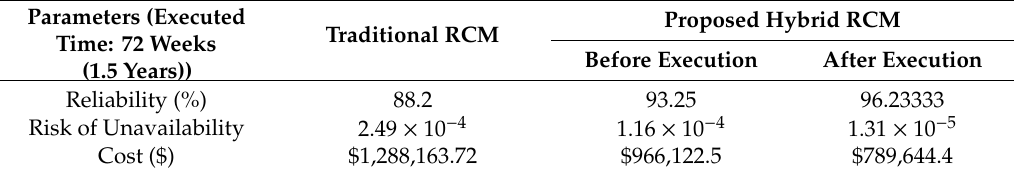
Table 7. The optimization results of RCM implementation.